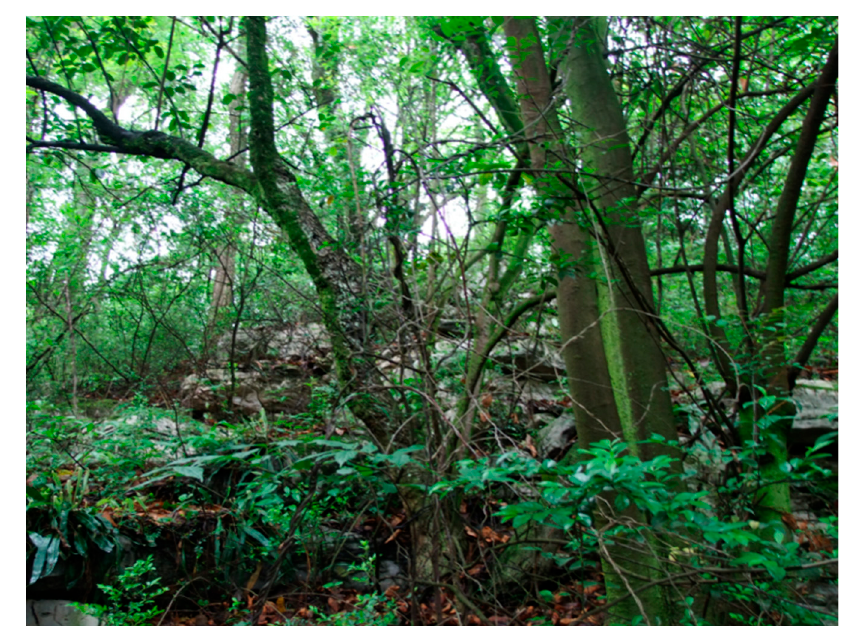
Figure 2. Example of an arbor forest (F) investigated in this study.